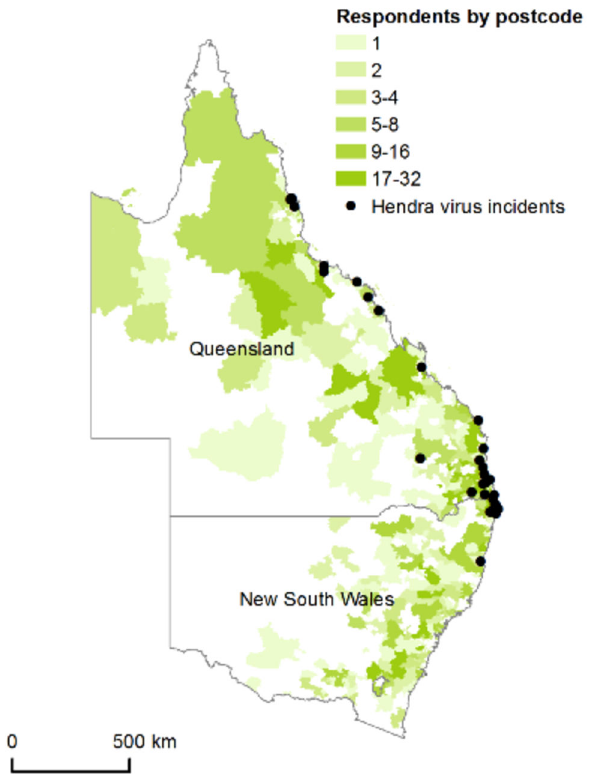
Figure 2. Map of eastern Australia illustrating the spatial distribution of the 1431 respondents from the target study population of Queensland and New South Wales, and indicating reported Hendra virus case locations.